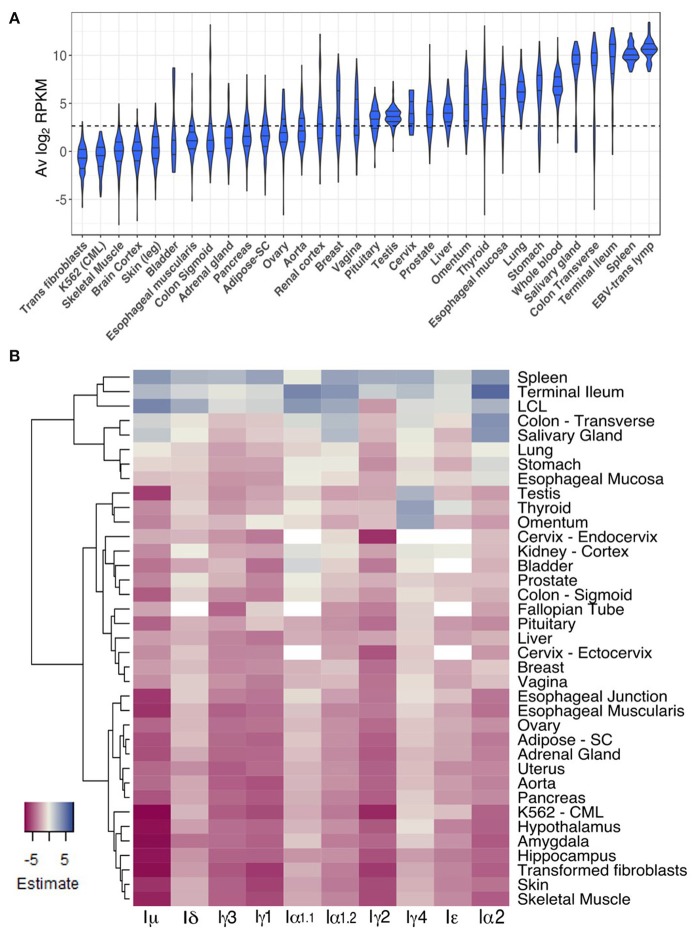
CSRnc transcription in healthy adult tissues. (A) The GTEx dataset was partitioned according to tissue type. Violin plot of average log2RPKM distribution of GTEx project representative tissues, ordered form left to right according to each tissue median log2RPKM. The violin area was scaled according to sample count and median and quartiles are shown. A dotted black line marks the mean average log2RPKM (2.65). For simplicity, only brain cortex was included as a representative sample for central nervous system. (B) Regression analysis of CSRnc transcription as a function of tissue type and I-exon. Whole blood CSRnc transcription was used as reference tissue (rows) for regression analysis according to I-exon (columns). The estimate for each comparison is expressed as a heatmap. Higher CSRnc transcription than in blood is represented in blue tones, whereas lower transcription is shown in pink tones. Zero estimate values are shown in ivory. Missing values (NA's) are shown in white. Euclidian distance was used for hierarchical clustering by row. For simplicity, only representative tissues are shown.